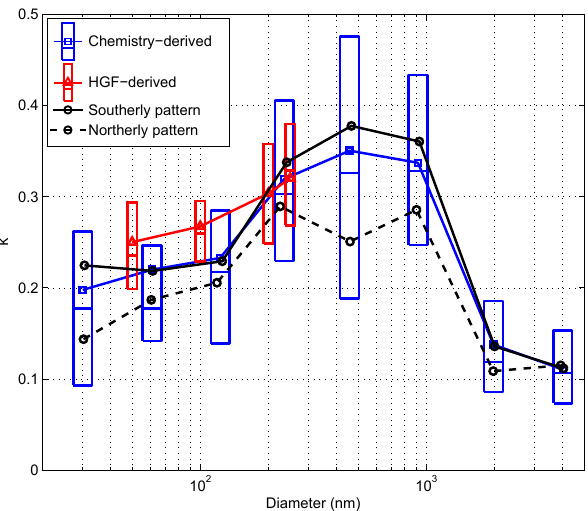
Fig. 5. The average κ curves during the campaign. Blue curve and boxes show the chemistry-derived κ values. Red curve and boxes show the HGF-derived κ values. Blue squares and red triangles rep- resent the campaign-average κ values. The central line, bottom and upper edges of boxes represent the medians, 25th percentile and 75th percentile of κ values for the individual impactor stage or the individual particle diameter. The solid curve and dashed curve rep- resent average values in the southerly pattern and in the northerly pattern, respectively.